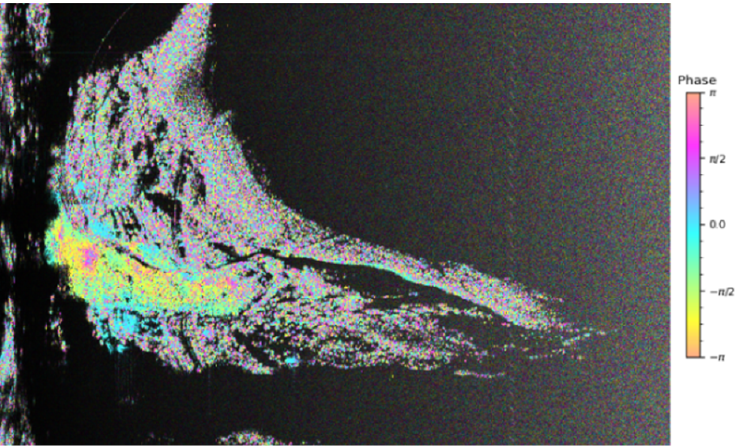
Figure 7. Interferogram result between 16:00 on the 17th and 16:00 on the 19th.